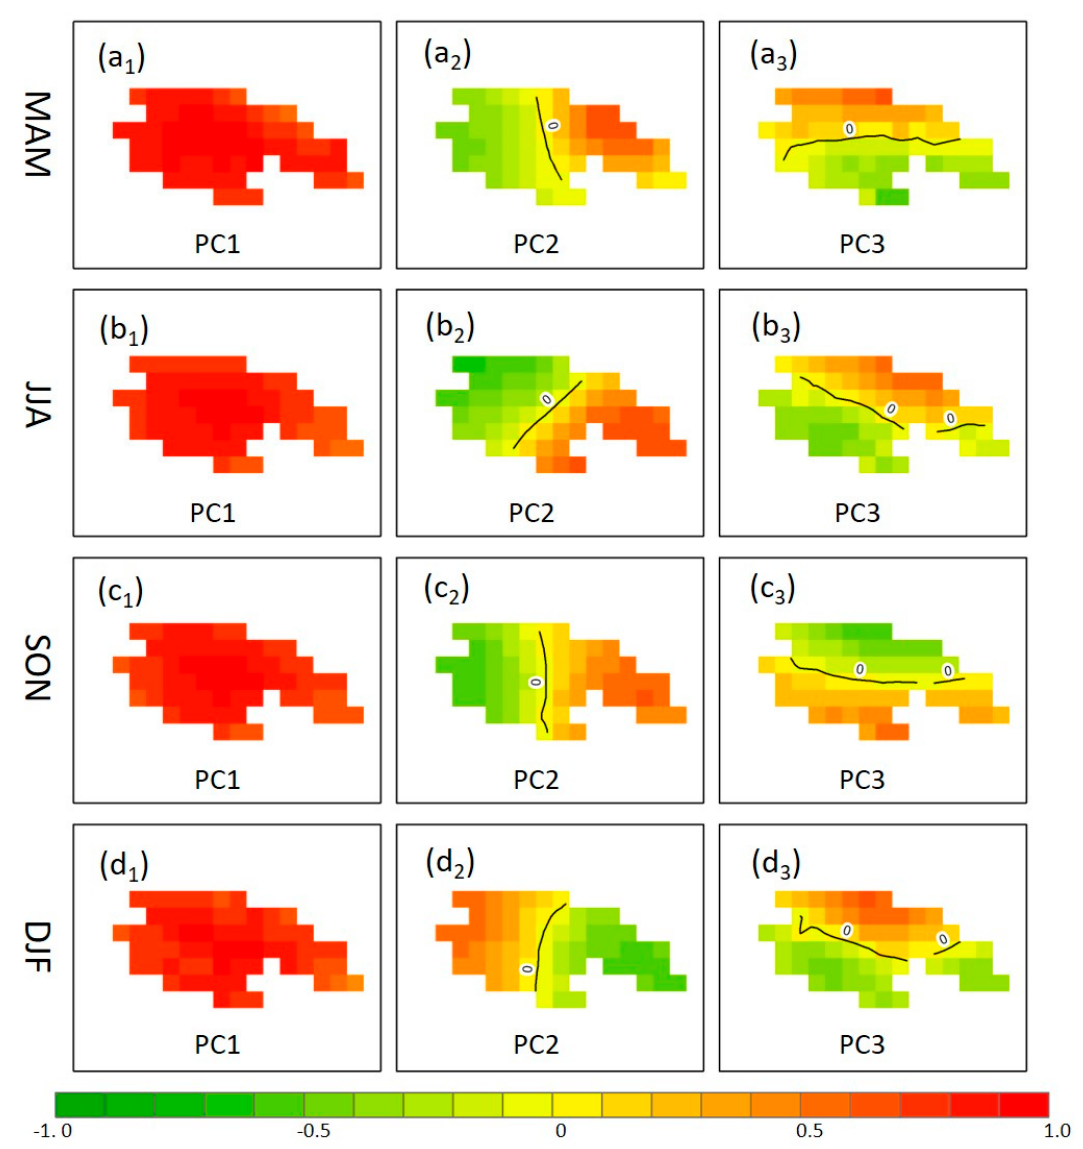
Figure 5. Spatial patterns for the leading three PCs of seasonal precipitation anomaly. (a 1 – a 3 ) PCs of Spring (MAM), ( b 1 – b 3 ) PCs of Summer (JJA), ( c 1 – c 3 ) PCs of Autumn (SON), ( d 1 – d 3 ) PCs of Winter (DJF).